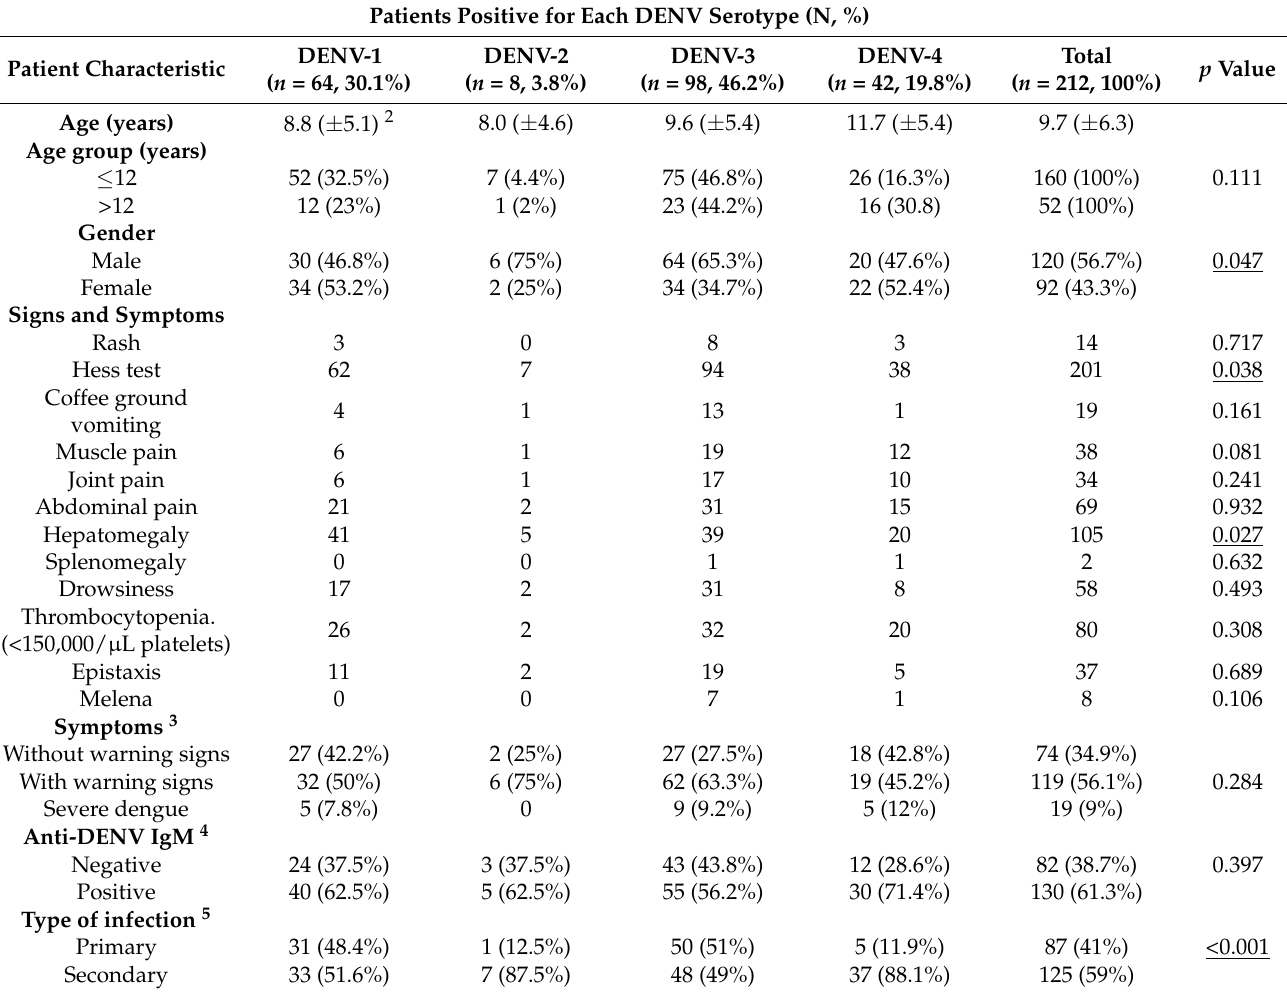
Table 2. Clinicopathological characteristics and laboratory findings of patients in the study cohort 1 . Patients Positive for Each DENV Serotype (N,